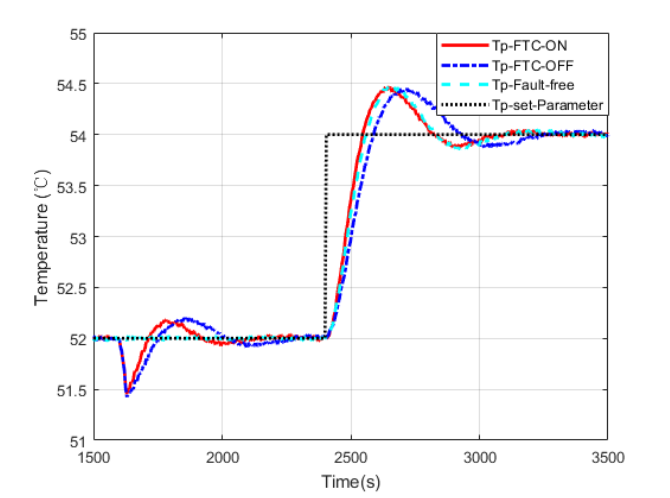
Figure 12. The simulation of a 45% fault case considering measurement